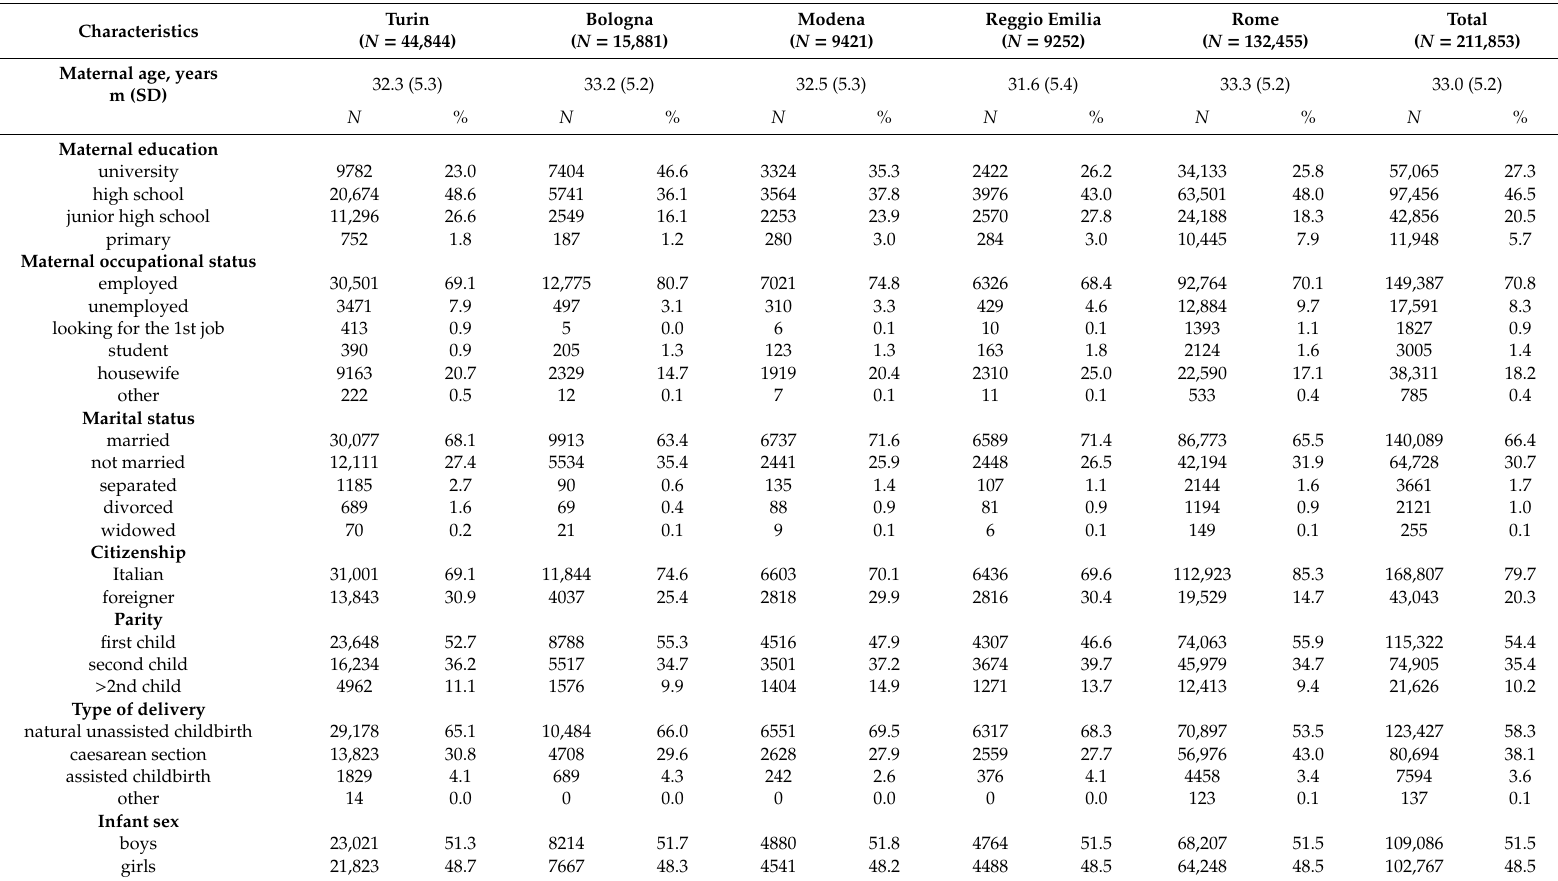
Table 2. Maternal and birth